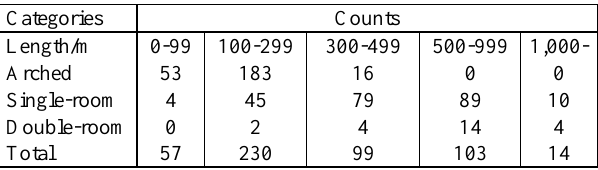
Table 2. Length segmented counts of GoogleEarth-based extracted STWs in Penghu